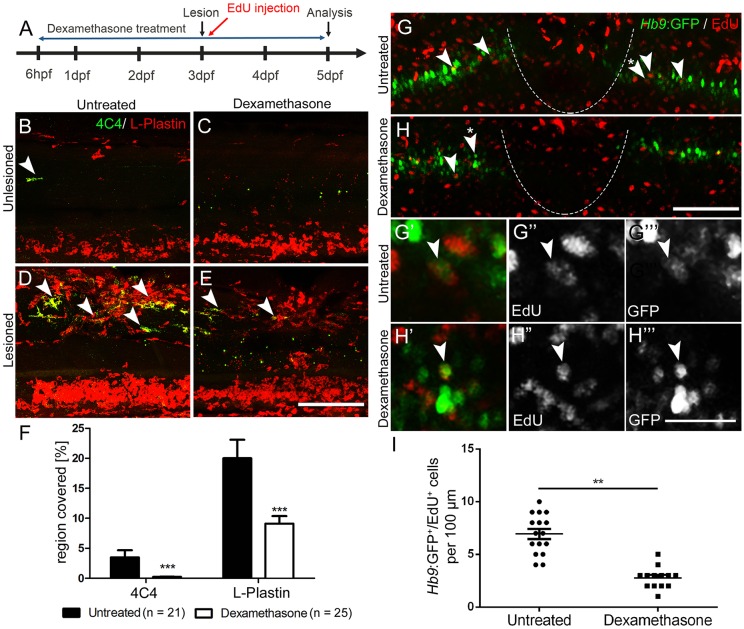
Suppression of the immune response inhibits motor neuron regeneration. (A) Time line for the experiments. (B-F) Incubation with dexamethasone does not lead to visible changes in unlesioned larvae (B,C), but strongly reduces the immune reaction at the lesion site (D,E) as indicated by reduced 4C4 (arrowheads indicate 4C4+ cells) and L-plastin immunoreactivity. Quantification of immunoreactivity is shown in F (Student's t-test, ***P<0.001). (G-I) Dexamethasone treatment reduces the number EdU-labelled Hb9:GFP+ motor neurons (arrowheads). Higher magnifications of double-labelled neurons indicated by asterisks in G,H are shown in single optical sections in G′-H‴. (I) Quantification of the reduction in newly generated motor neurons (t-test; **P=0.0085; unlesioned, n=16; dexamethasone, n=13). Lateral views are shown; rostral is left, dorsal is up. The lesion site is indicated by a dashed line. Values are means±s.e.m. Scale bars: 100 µm in E for B-E; 100 µm in H for G,H; 50 µm in H‴ for G′-H‴.